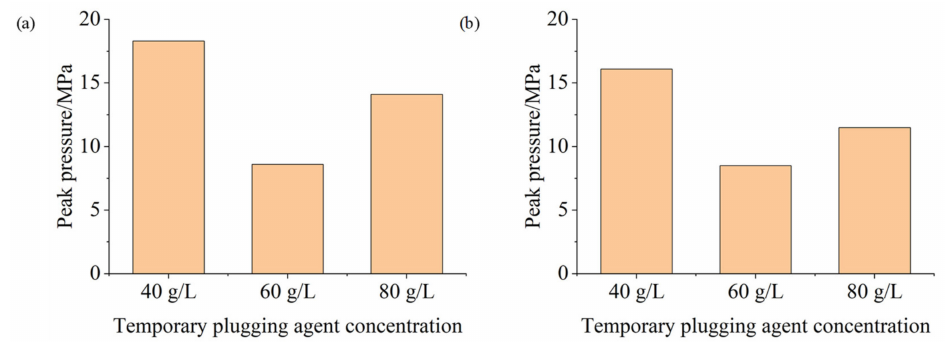
Figure 9. Relationship between concentration of the temporary plugging agent and peak pres- sure of intrafracture and intrastage temporary plugging fracturing: ( a ) Intrafracture peak pressure; ( b ) intrastage peak